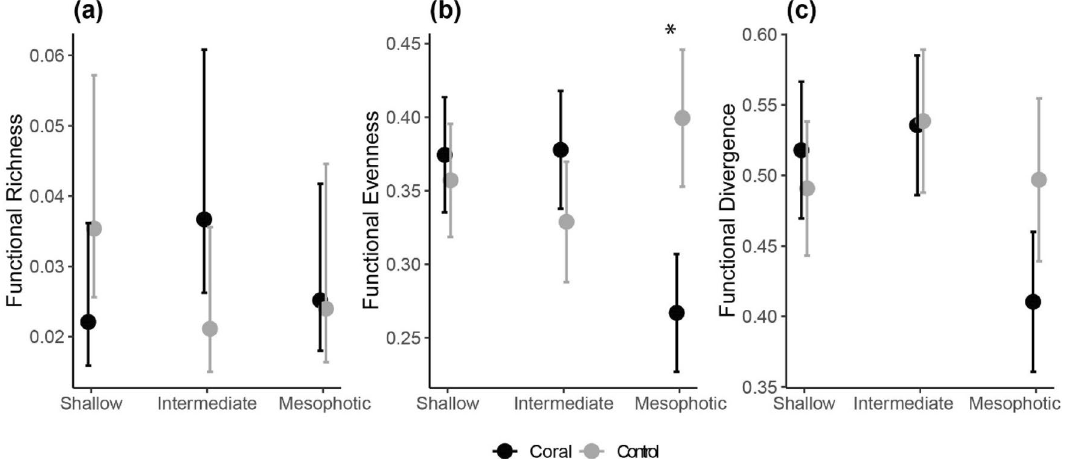
Figure 3. Predicted differences in functional ( a ) richness, ( b ) evenness, and ( c ) divergence among depth strata for coral (black) and control (grey) sites. Dots are model-averaged predictions from GLMMs, and whiskers are standard errors around the predicted mean. Significant differences (α = 0.05) between control and coral sites for each depth strata are indicated with an